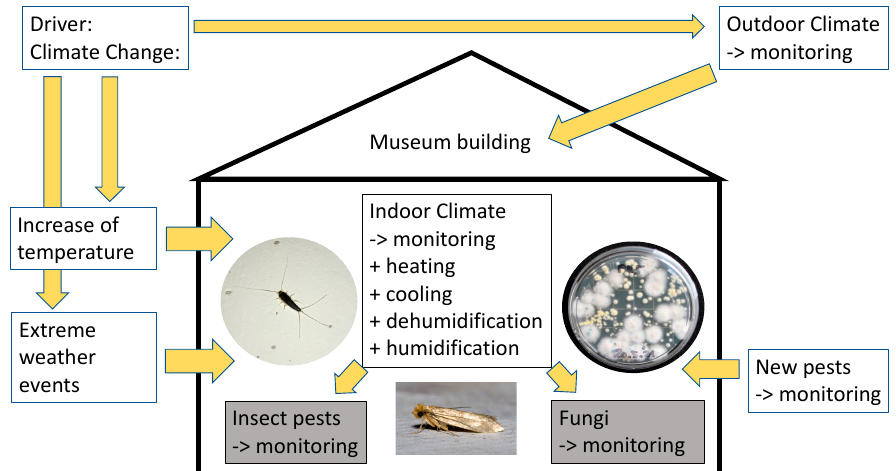
Figure 1. Relationship between climate change, outdoor climate, indoor climate, and insect and fungi monitoring.